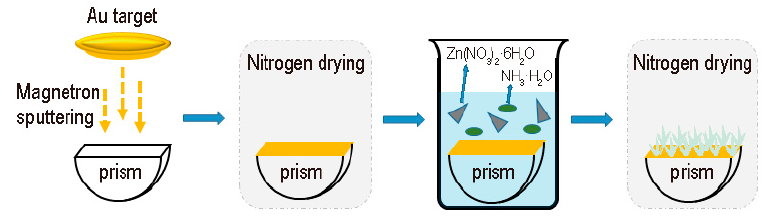
Figure 1. Schematic diagram of synthesis process.